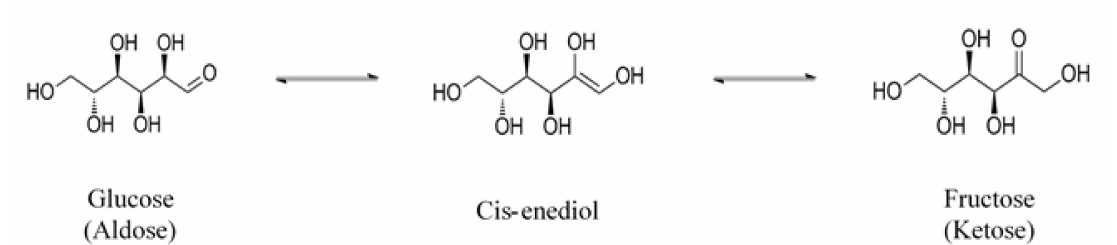
Figure 2. Proposed mechanism of isomerization of glucose into fructose with glucose isomerase (GI) via the Lobry–de Bruyn–van Ekenstein